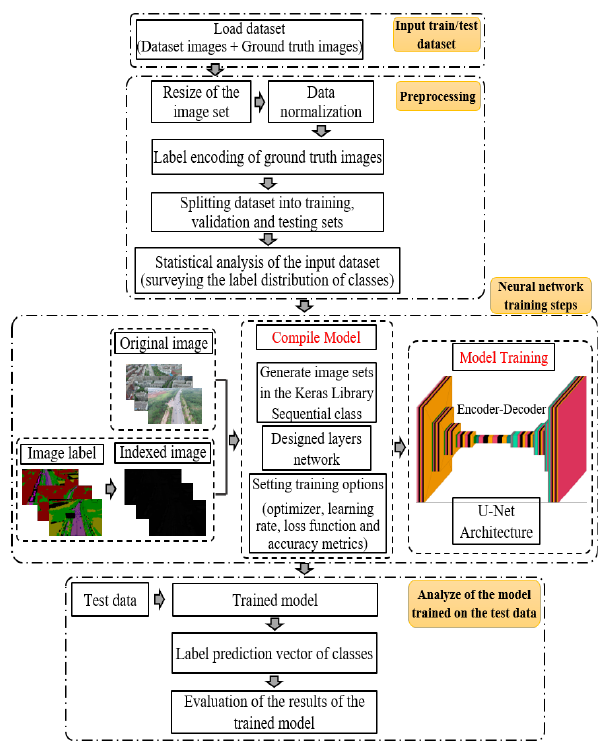
Figure 1 . Flowchart of the proposed method.